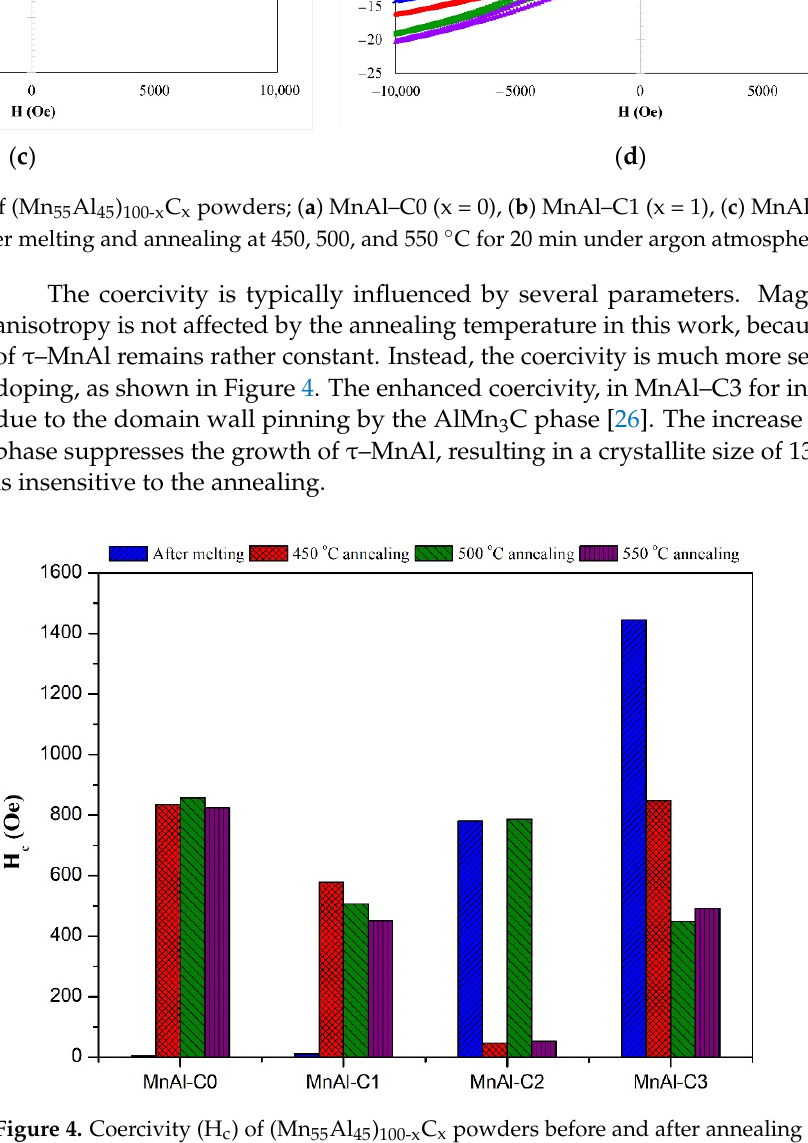
Figure 4. Coercivity (H c ) of (Mn 55 Al 45 ) 100-x C x powders before and after annealing for 20 min at 450, 500, and 550 °C under argon atmosphere.